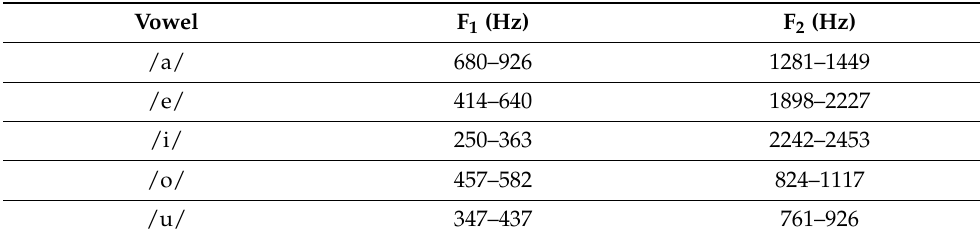
Table 2. Frequency range of the formants F 1 and F 2 of the five vowels for a male speaker obtained by a lateral inhibition